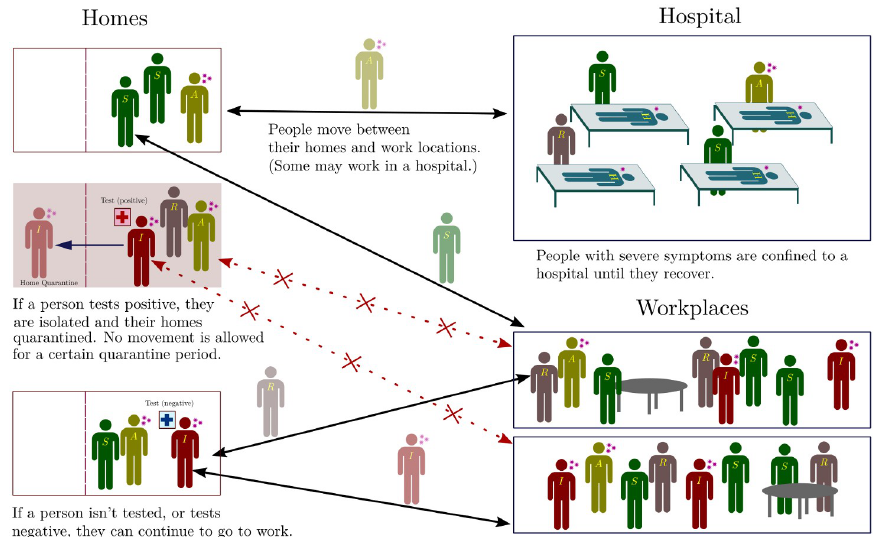
Fig 2. Schematic of the network. Individuals exist on a location network, consisting of homes and work places, connected by links along which people can move. For each individual there is a link between their home and their work place. Within each location, individuals can transition between the different infection states described in Fig 1. A subset of work places are designated as hospitals, where people are moved (and quarantined) when they transition from the SI to the H state. When they recover, they are moved back to their homes and can resume movement between their home and work. In addition, if a person tests positive they and their home are quarantined, with no movement being allowed out of the home for 14 days (we explore several variants of this protocol as described in subsequent sections). state of the individual. Yellow links represent susceptible individuals, red links represent those infected and green links represent those who have recovered.